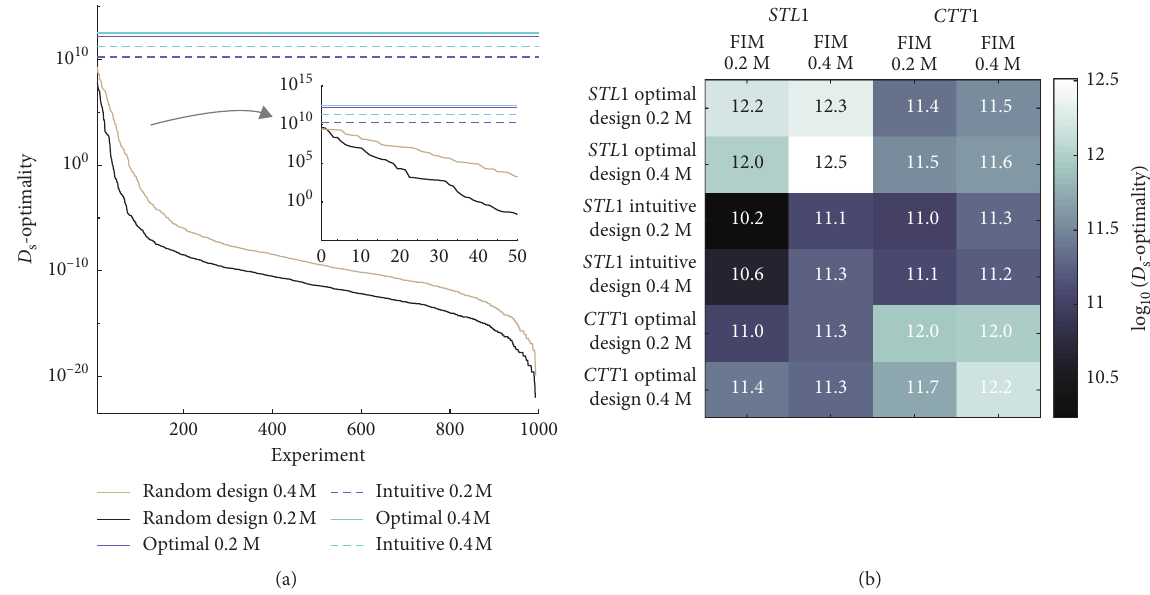
Figure 4: Information gained by performing optimal experiments compared to actual experiments. (a) D s -optimality for optimal design using three time points compared to the intuitive experiment designs made using 16 time points is shown with horizontal lines (purple, 0.2M, and blue, 0.4M). Solid horizontal lines denote the optimal designs and dashed lines represent intuitive experiment designs. Randomly designed experiments with 0.2 M and 0.4M NaCl are shown in black and orange. For the random experiments, the time points were selected by sampling them from the experimental measurement times, and then a random number of measurements were assigned to each selected time point. The inset shows the first 50 randomly designed experiments. (b) The D s -metric for different experiment designs (different rows) when applied to different genes or different experimental levels of osmotic shock (different columns). Lighter shades (higher D s -metrics) indicate experimental designs that are more suitable to identify